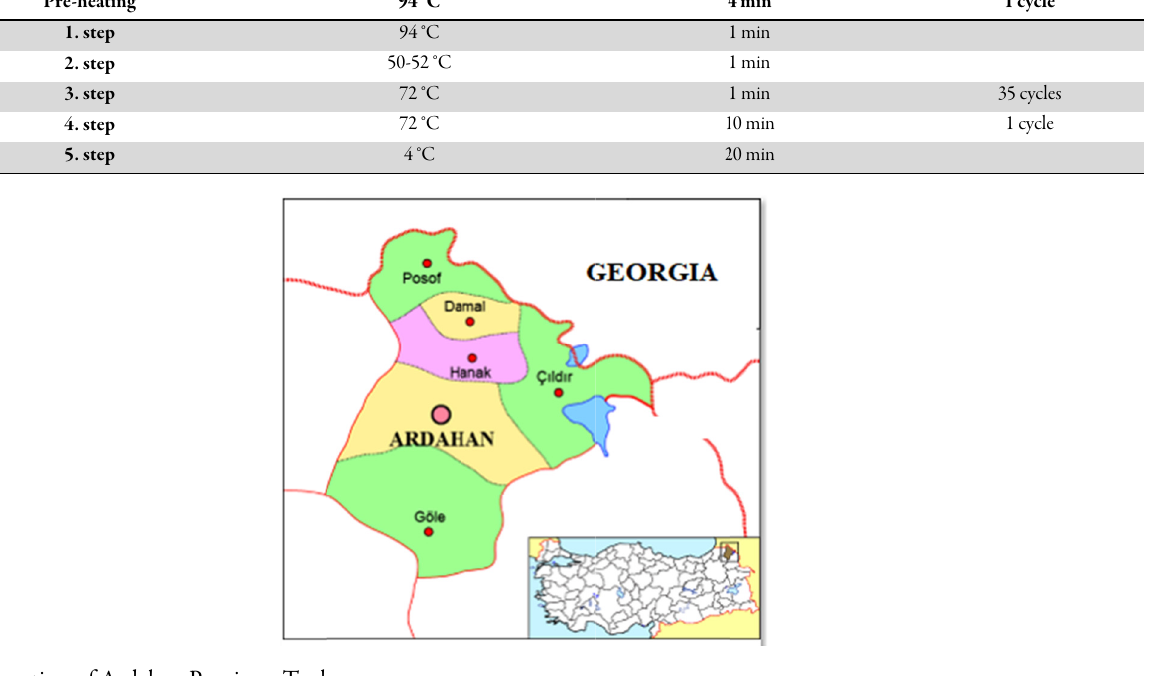
Fig. 1. Location of Ardahan Province,